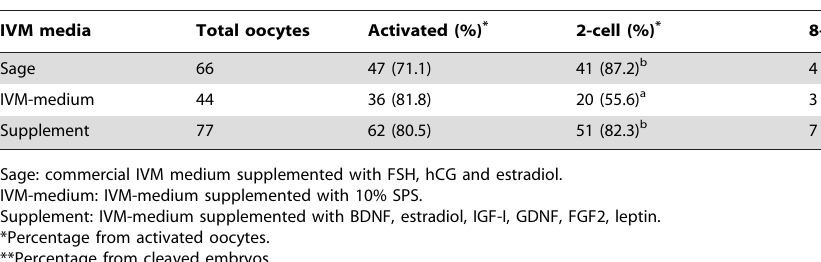
Table 2. Embryo development after parthenogenetic activation of human oocytes matured in vitro .